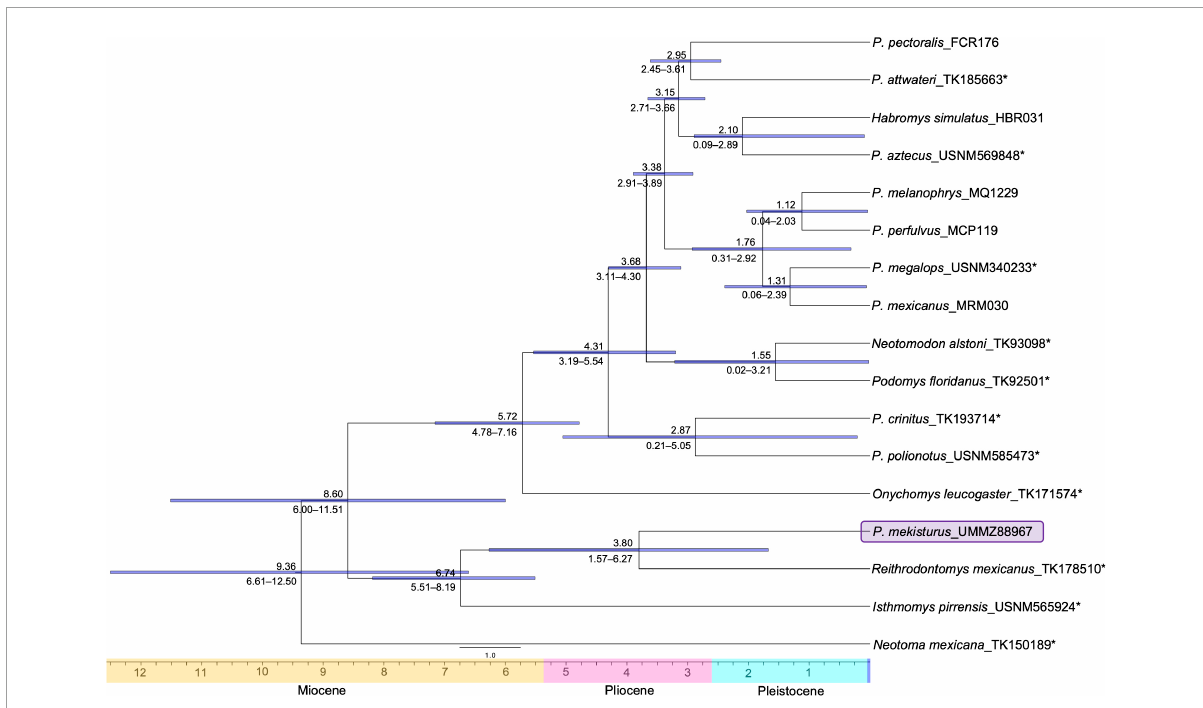
FIGURE4 Divergence dated nuclear phylogeny based on 417 UCE loci (95% matrix, N = 17). Dates above the branches are provided in millions of years. Blue horizontal bars and numbers below the branches show the 95% confidence intervals. The purple block shows the phylogenetic position of the Peromyscus mekisturus specimen collected in 1947. Asterisks* denote specimens that were sequenced from museum specimens for this